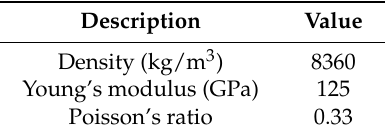
Table 1. Material properties of